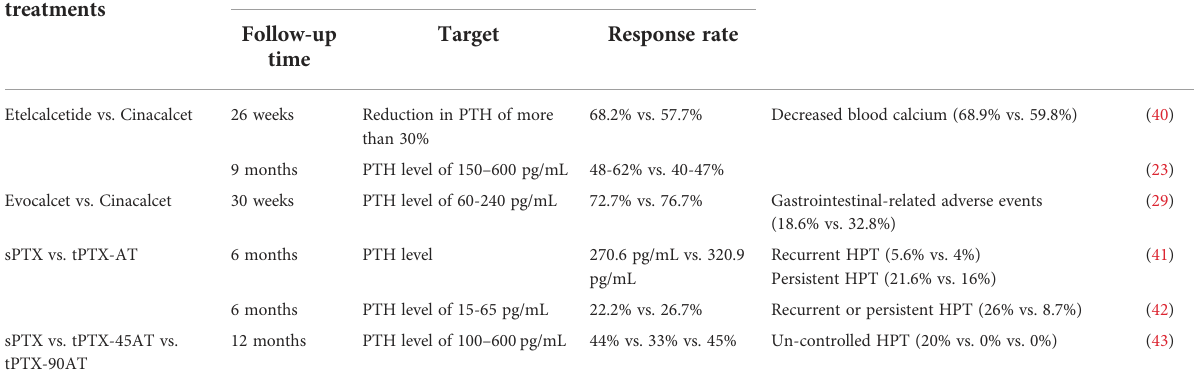
TABLE 1 Comparison of treatments. Comparison